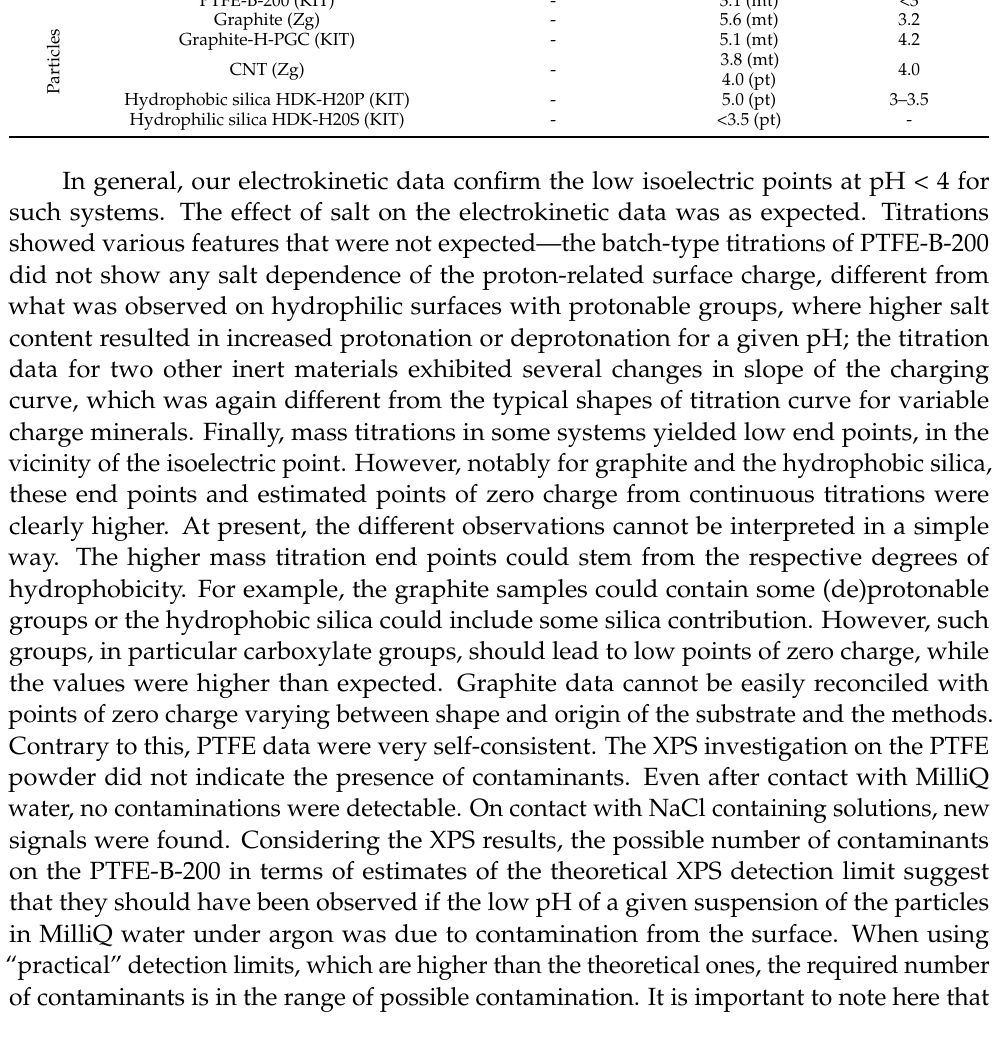
Methods Streaming Potential/Current Titration Electrophoresis pH